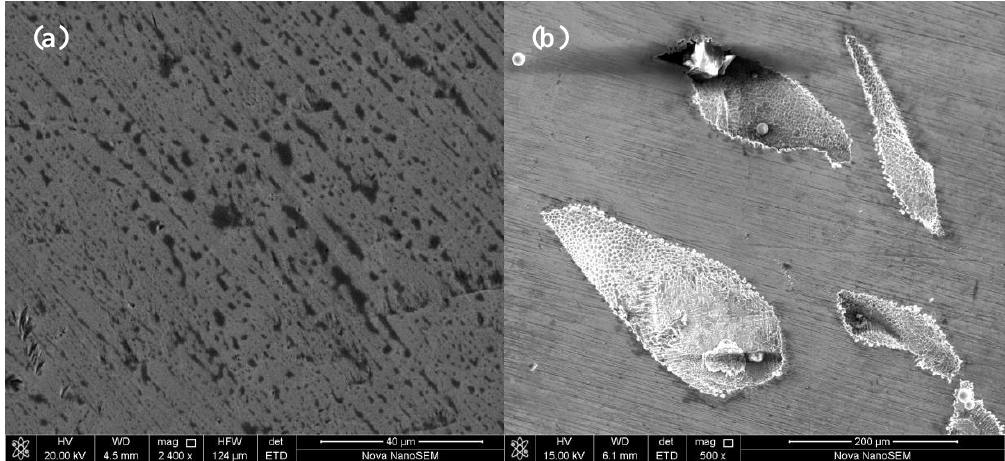
Figure 8. Surface morphology of CoCrFeNiTi x HEA coating after the polarization test: ( a ) low magnification, ( b ) high magnification.